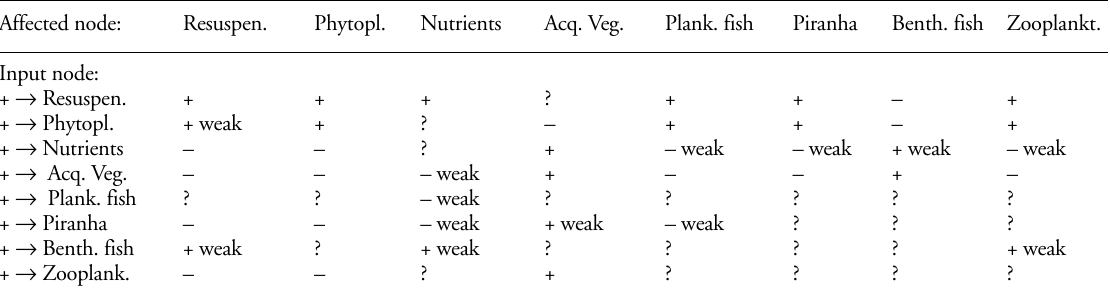
Table 2. Prediction table for qualitative model for feedback between system variables in the neotropical wetland (Esteros del Ibera). Model variables which have been affected include: nutrients (considered those that would effect vegetation growth), aquatic macrophytes (rooted emergent and submersed aquatic vegetation), phytoplankton, resuspension of lagoon sediment (consisting of fine organic material), zooplankton, small planktivorous fish, piranha and benthivorous fish. Affected node: Resuspen. Phytopl. Nutrients Acq. Veg. Plank. fish Piranha Benth. fish Zooplankt.